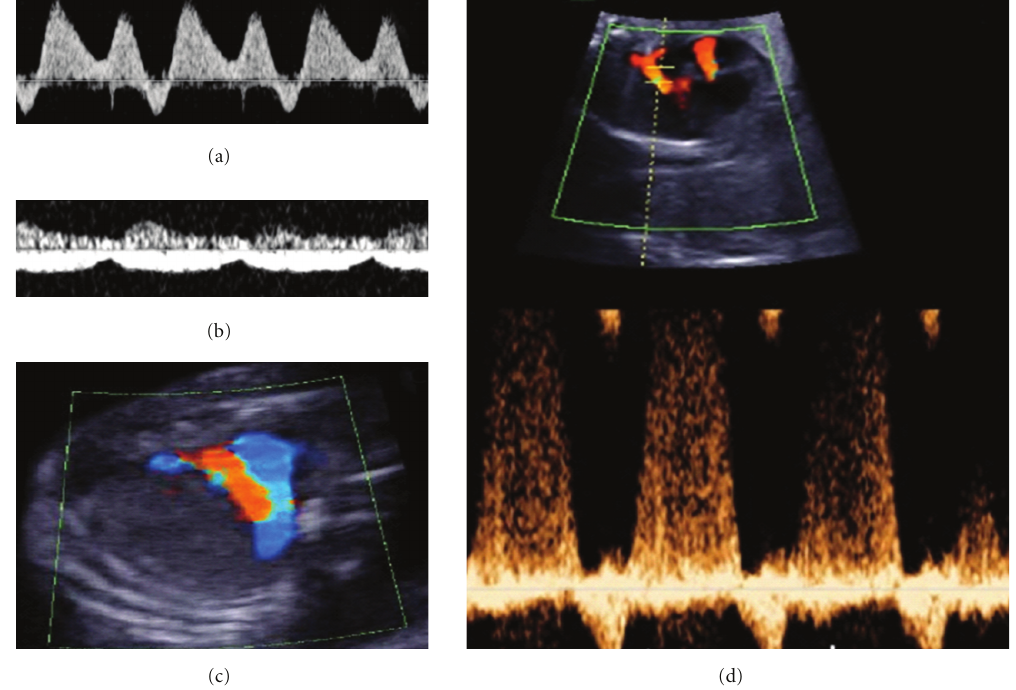
Figure 1: Common echocardiographic findings in the recipient of TTTS. (a) Reversed flow in the ductus venosus. (b) Umbilical vein pulsations. (c) Transverse view of the fetal chest at the level of the 3-vessel view demonstrating forward flow in the aorta (blue) and reversed flow in the ductus arteriosus and pulmonary artery (red) suggestive of functional pulmonary atresia. (d) Doppler assessment at the level of the fetal 4-chamber view demonstrating mitral and tricuspid regurgitation with the corresponding pulsed Doppler spectrum